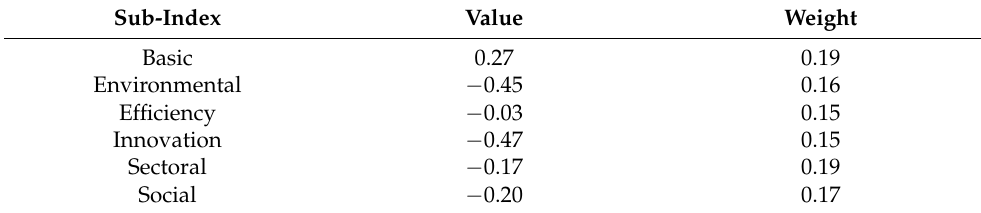
Table 2. Sub-index values and